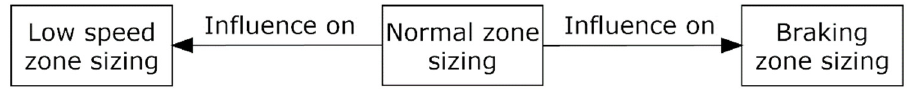
Figure 32. Zone sizing